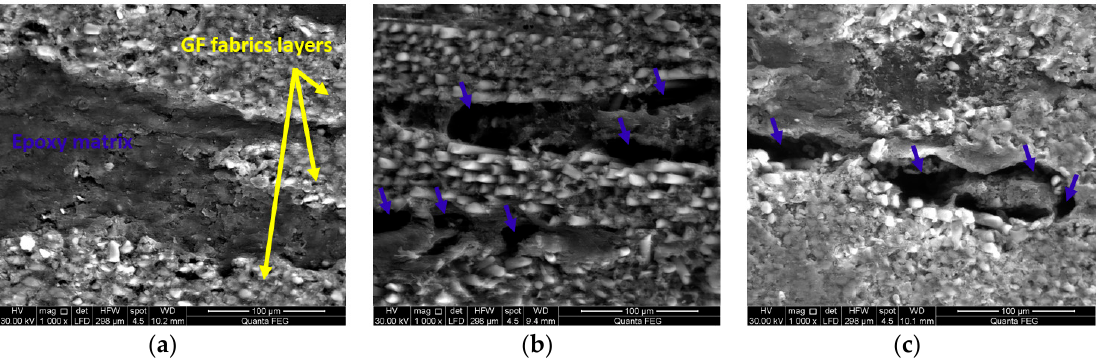
Figure 16. FESEM images for ( a ) dry CNFs/GFRP; ( b ) CNFs/GFRP after 100 days exposure at 22 °C and ( c ) CNFs/GFRP after 100 days exposure at 45 °C. The yellow arrows mark the glass fiber fabric layers and blue arrows mark some micro-cracks in the matrix.